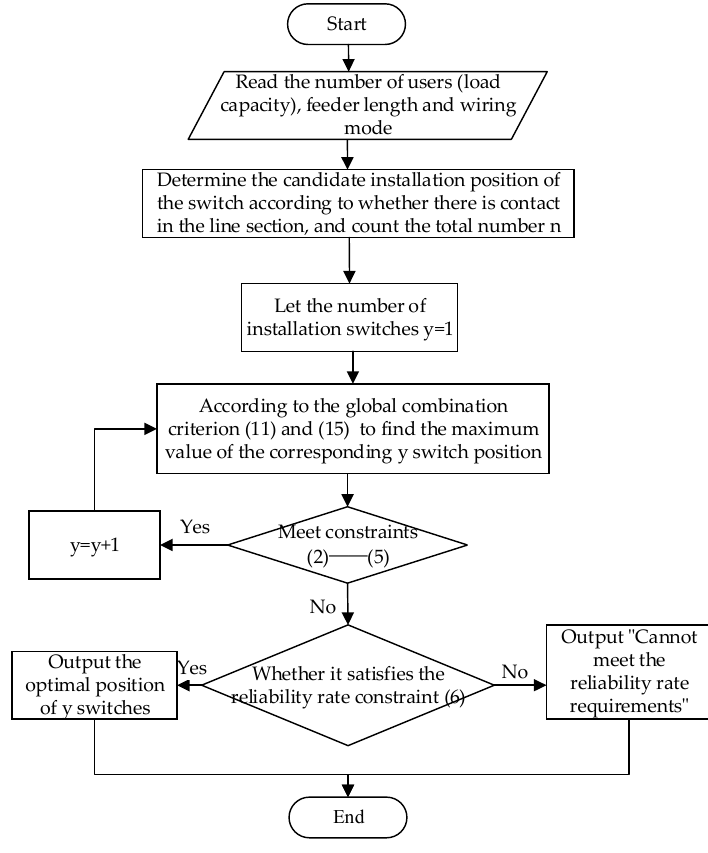
Figure 5. Algorithm flowchart.